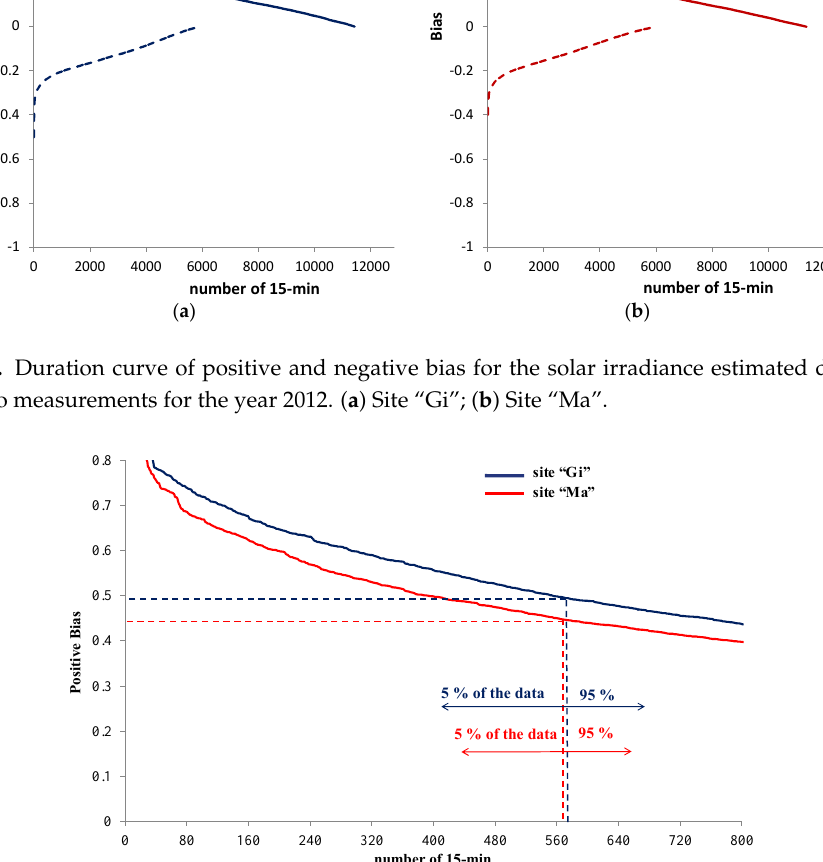
Figure 8. Zoom of the duration curves of positive bias for the solar irradiance estimated data with respect to measurements for the year 2012 at the sites “Gi” and “Ma”. Energies 2016 , 9 , page–page